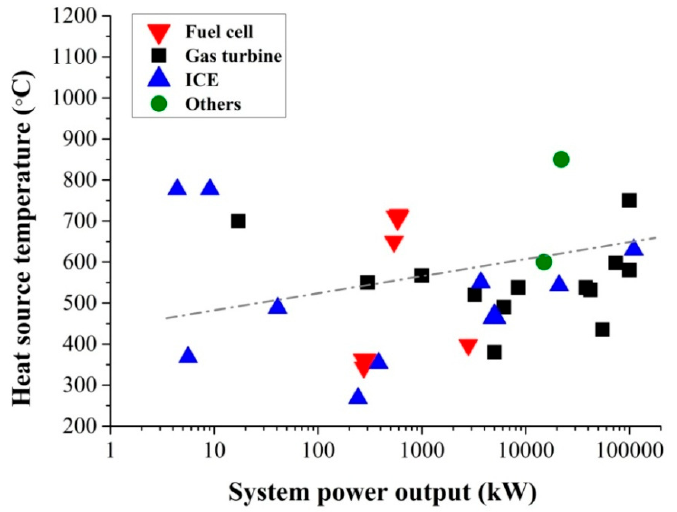
Figure 6. Heat source temperature vs. system power output (s-CO 2 bottoming cycle) based on database in Table 1.